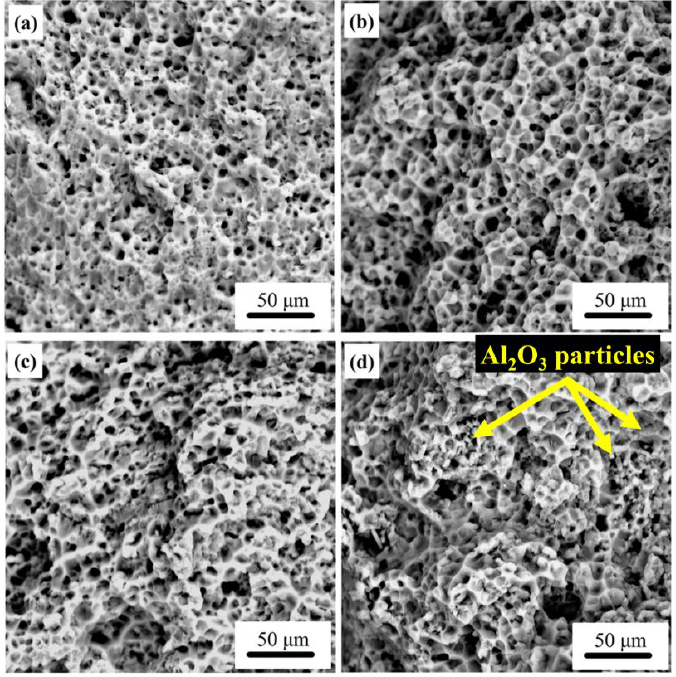
Figure 5. The tensile true stress-true strain curves of Al-12Si/Al 2 O 3 nanocomposites produced by the hot extrusion method. Table 2. Tensile properties of the as-extruded Al-12Si/Al 2 O 3 nanoparticle-reinforced composites.